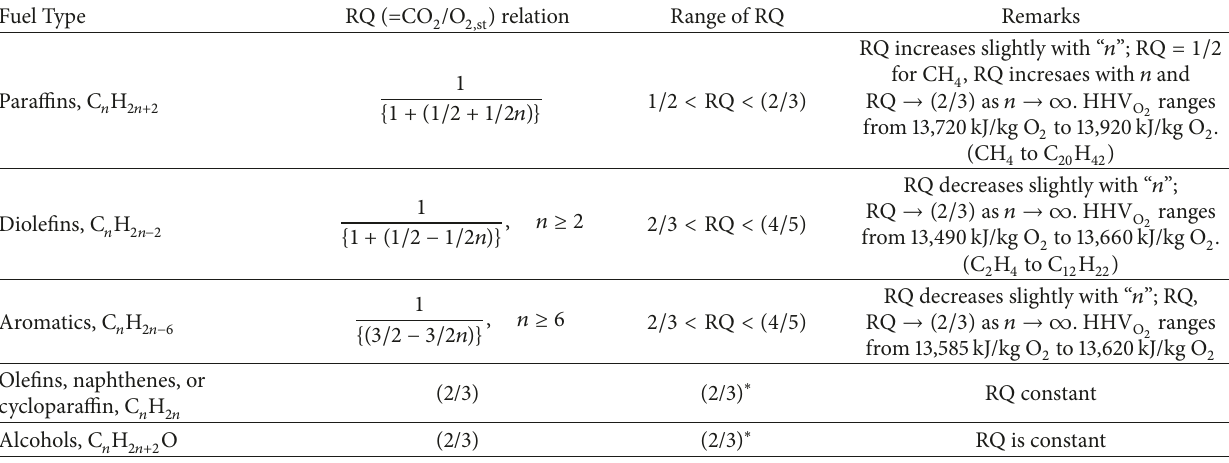
Table 3: Estimated RQ factors for hydrocarbon, alcohol, aromatics, and cycloparaffin fuels. CO 2 in tons per GJ ≈ RQ ∗0.1 ; CO 2 in short tons per MMBtu = RQ ∗ 0.116 ; RQ = ( C , mass% /12.01)/{( C , mass% /12.01) + (1/4)( H , mass% /1.01) − (1/2)( O , mass% /16) + ( S , mass% /32.06)} ;